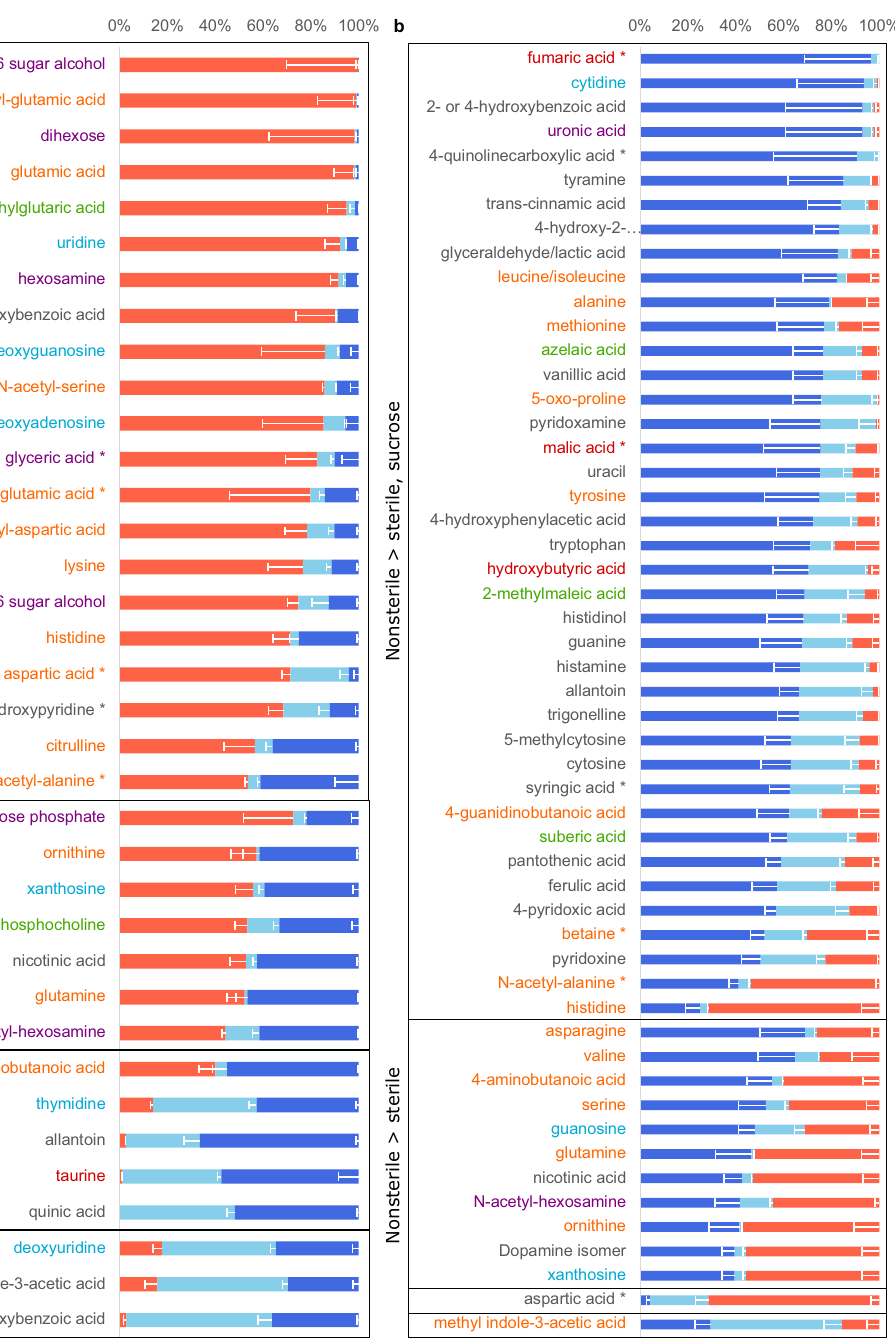
Fig. 3 | Metabolites distinct in B. distachyon exudates from different growth conditions. Normalizedpeakheightof metabolitessigni fi cantly differentbetween growth conditions (light blue: sterile, red: sucrose supplemented, dark blue: non- sterile)(Anova/Tukey test, p <0.05, p -values are given in Supplementary Data 1). Sucrose-supplemented vs sterile conditions a , nonsterile vs sterile conditions b . Displayed are all conditions as reference, black boxes and labeling to the left indicate in which conditions a metabolite is distinct, and if it its abundance is